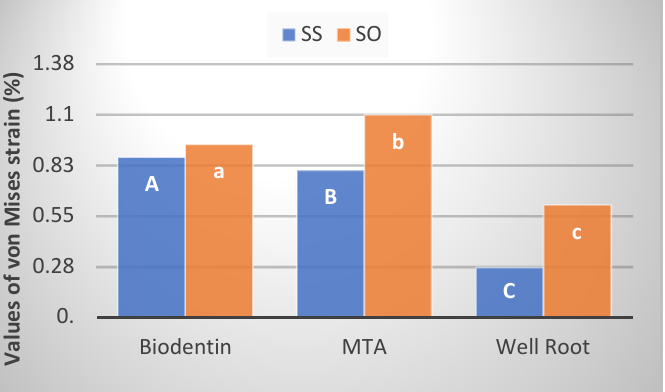
Figure 10. Bar chart shows mean values of von Mises strain in both zones, central (SS) and peripheral (SO), measured on Teflon discs. Significant differences in the central zone are marked with different upper-case letters and those in the peripheral zone are marked with different lower-case letters. Table 3. Results of paired T-test for differences between two measures zones (SS and SO) for three materials in dentin and Teflon.